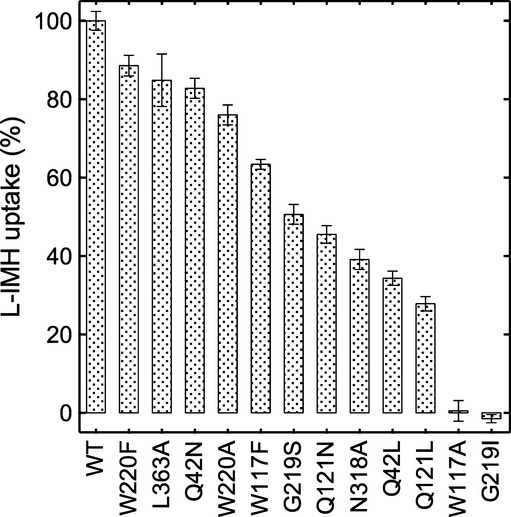
Impairment of hydantoin uptake in mutants of Mhp1The accumulation of 14C-L-IMH (50 μM initial external concentration) was measured for 15 s in cells expressing the wild-type or mutant Mhp1 proteins (Materials and Methods and Supplementary Methods). All measurements were normalised to percentages by comparison with the wild-type value of 0.57 ± 0.01 (s.e.m., n = 34) nmol/mg dry mass. Error bars represent the s.e.m. of at least triplicate measurements. All assays were performed in the presence of 150 mM NaCl.